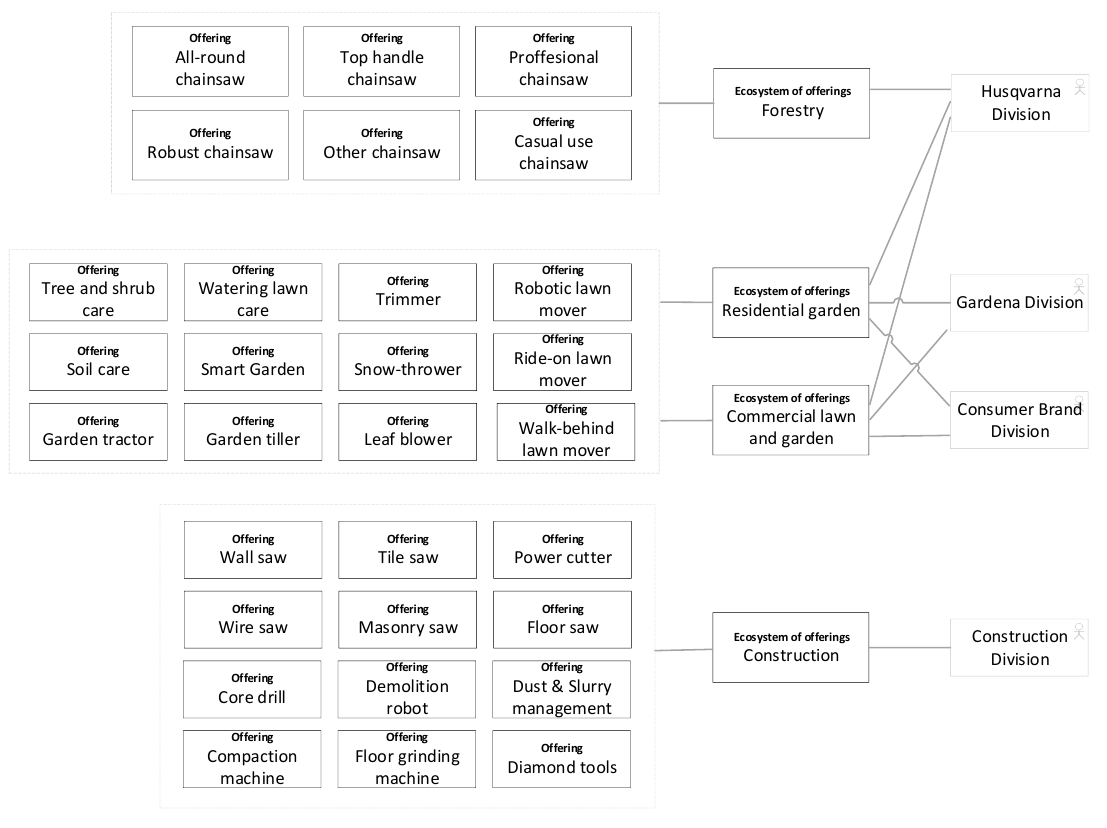
Figure 6. Ecosystems of offerings, the key offerings and involved actors